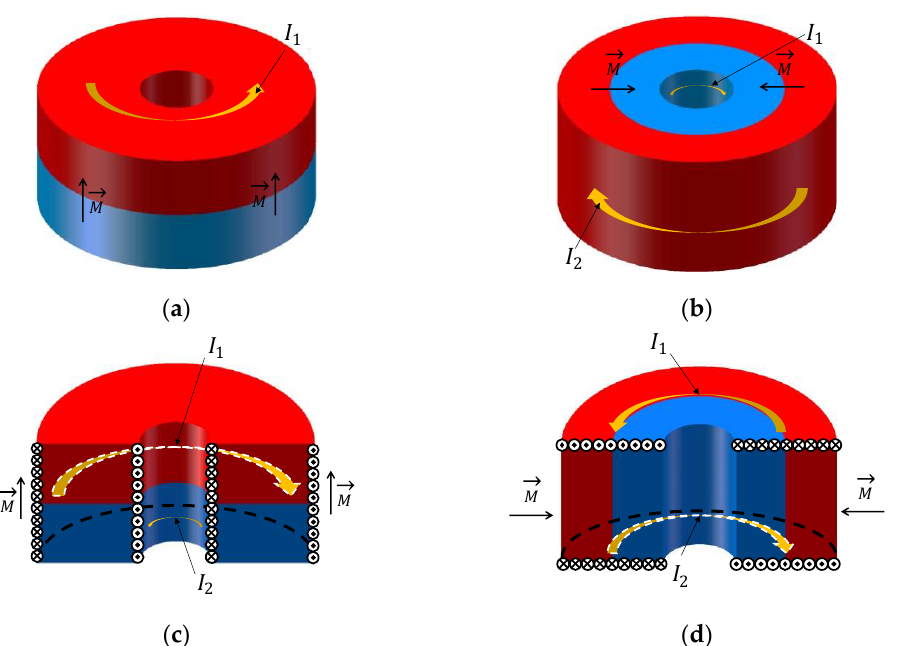
Figure 5. Two magnetization directions for magnet loops. ( a ) Magnet loop that is magnetized axially; ( b ) magnet loop that is magnetized radially; ( c ) molecular currents distribution for magnet loop that is magnetized radially in full-sectioned view; ( d ) molecular currents distribution for magnet loop that is magnetized radially in full-sectioned view. The solid points and fork represent opposite current-flow directions.